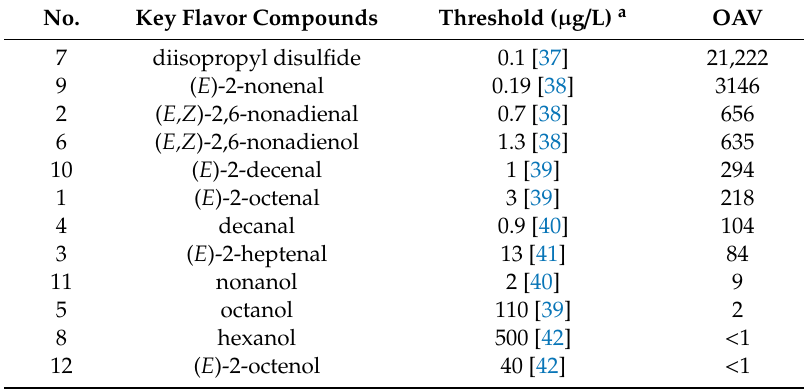
Table 4. Odor activity values (OAV) of aroma-active and key o ff -flavor compounds. No. Key Flavor Compounds Threshold ( µ g / L) a OAV 7 diisopropyl disulfide 0.1 [37] ( E,Z